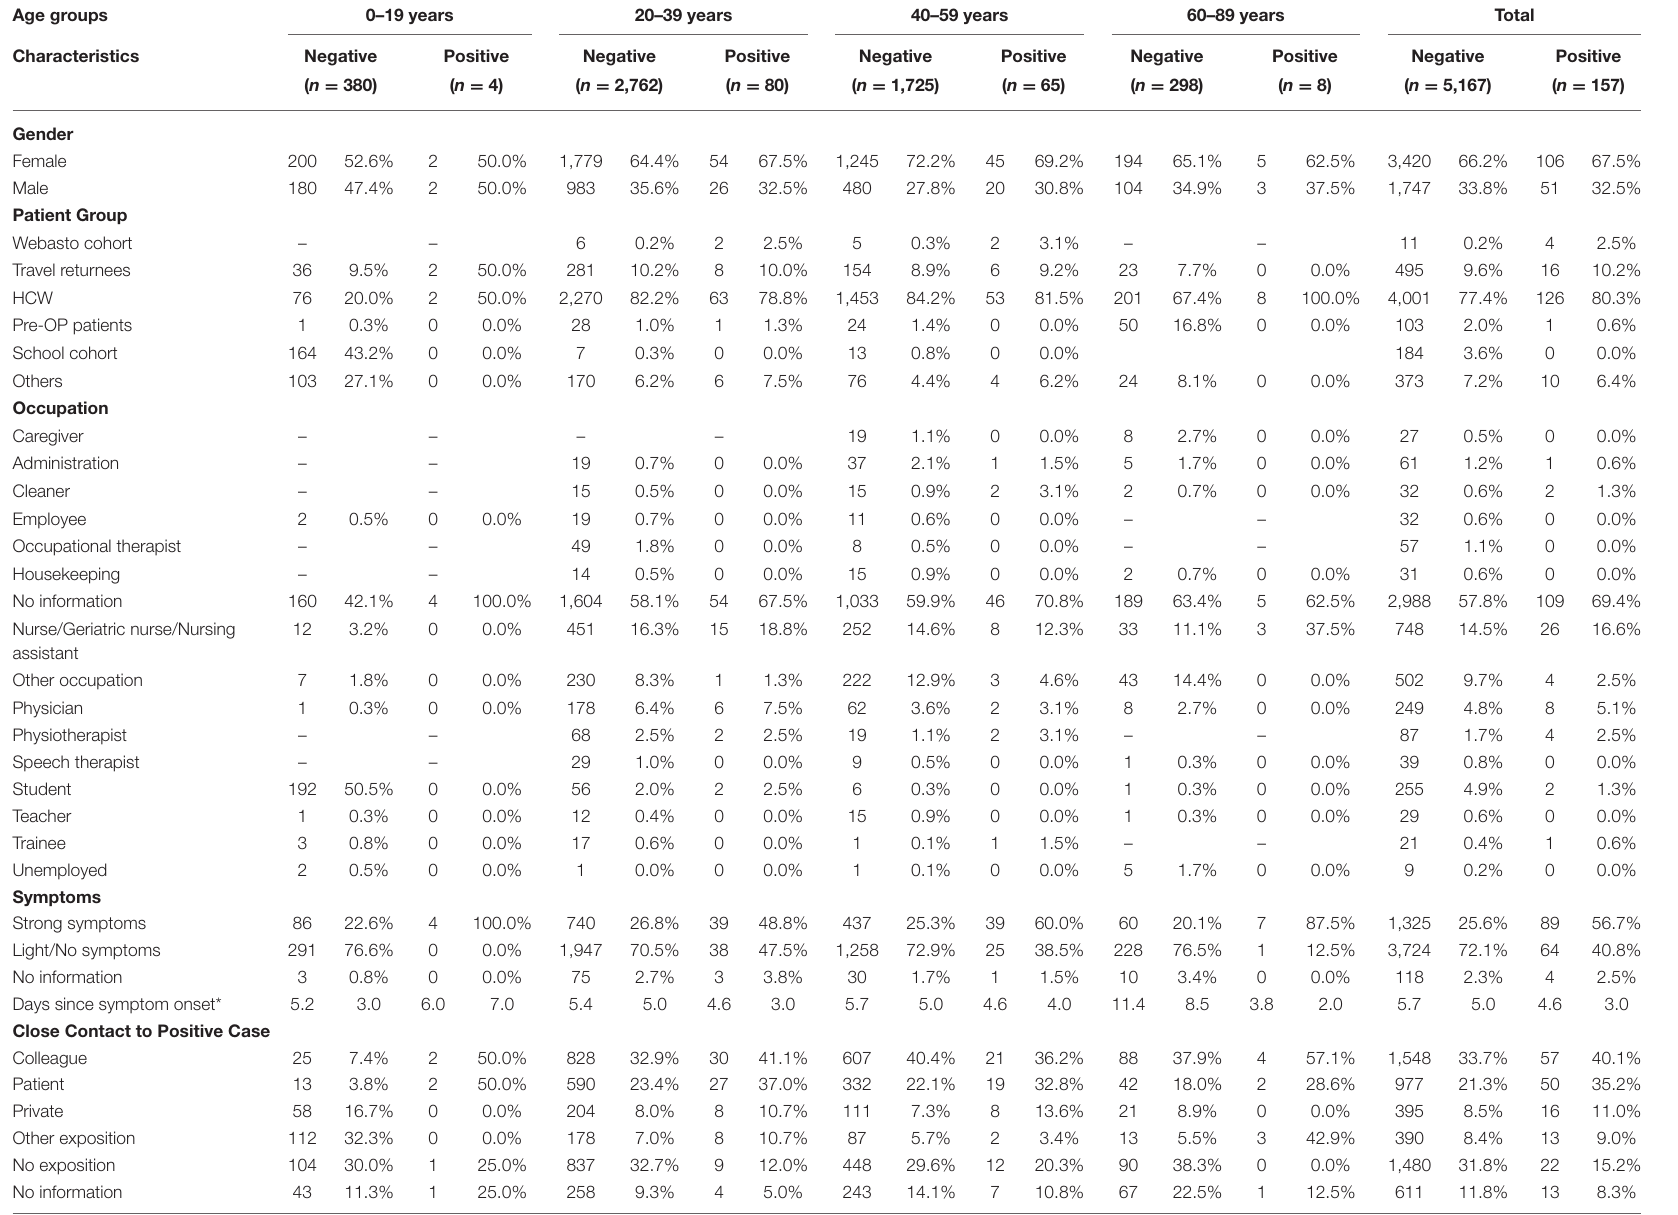
TABLE 1 | Patient characteristics: frequency and percentage by age group and test